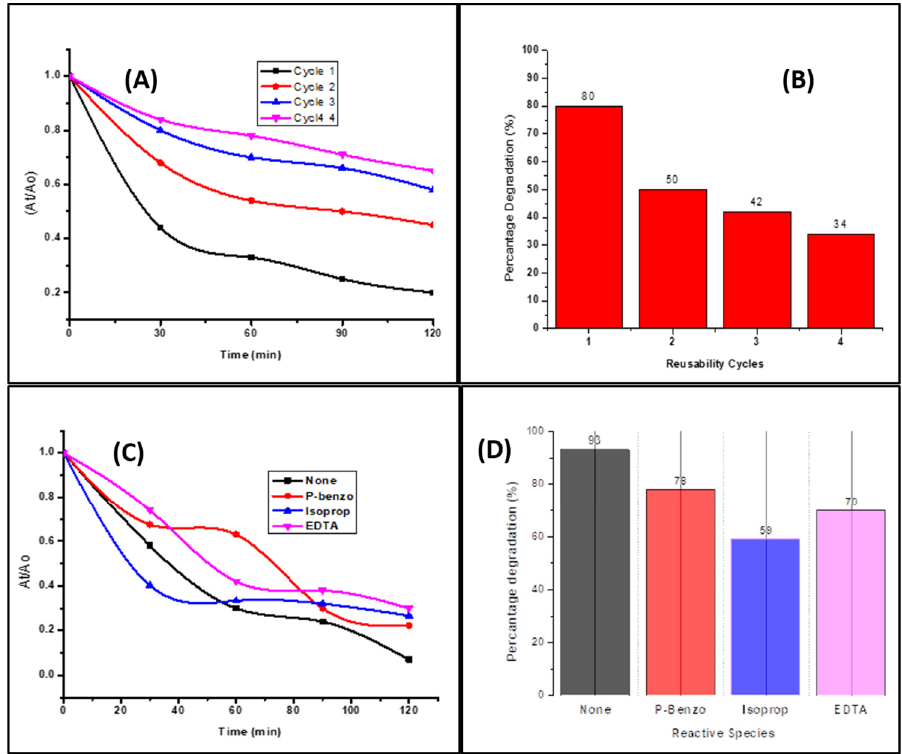
Figure 12. ( A , B ) Reusability studies, ( C , D ) effect of reactive